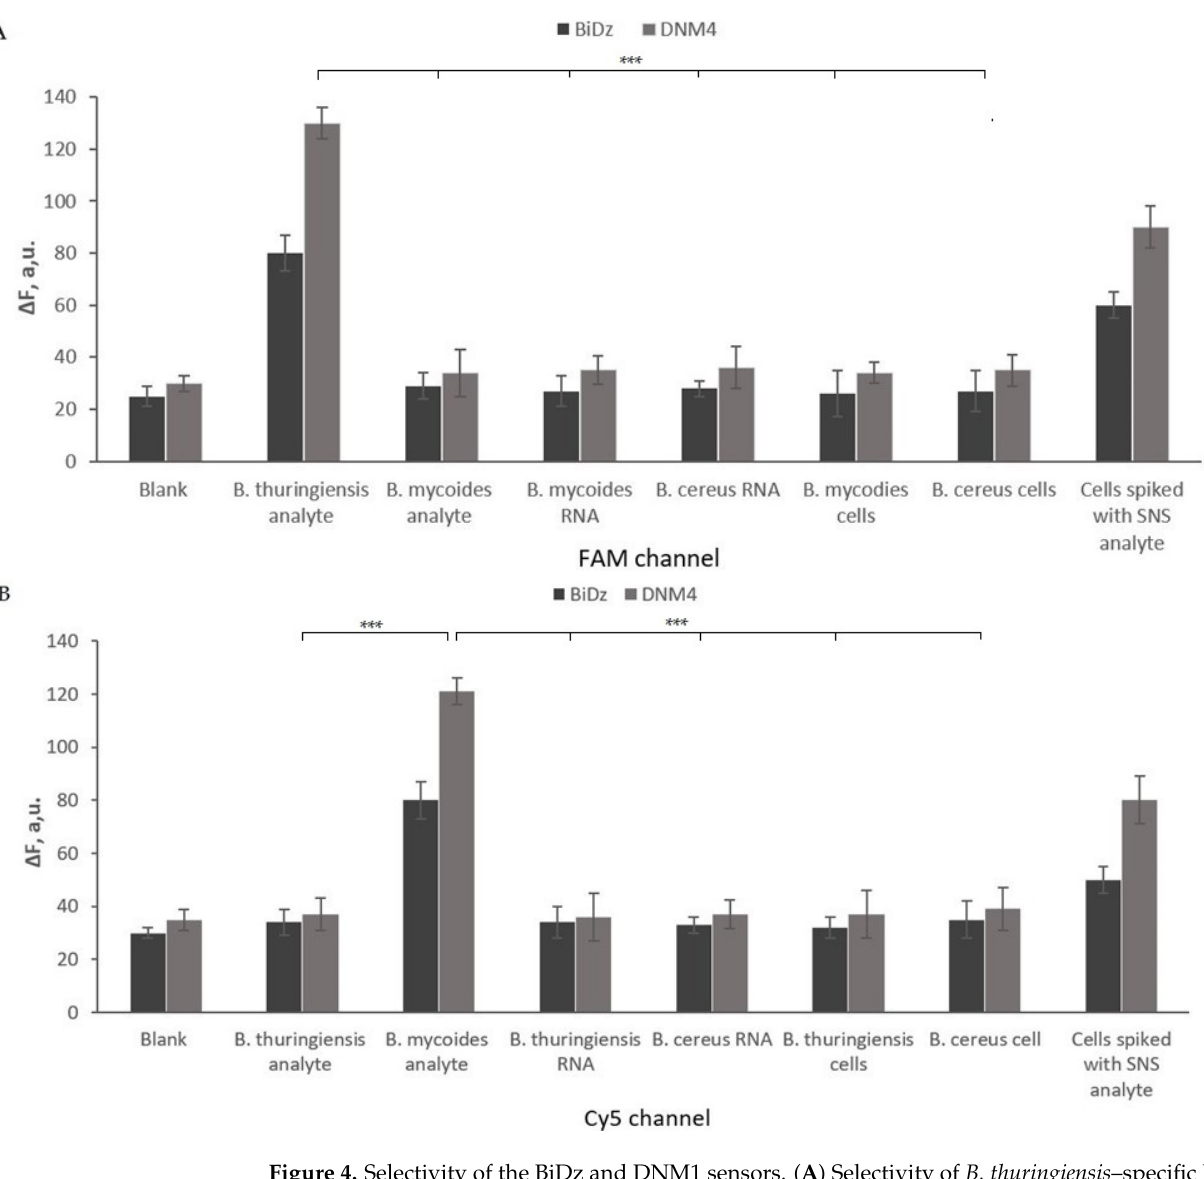
Figure 4. Selectivity of the BiDz and DNM1 sensors. ( A ) Selectivity of B. thuringiensis –specific BiDz (dark gray bars) and DNM4 (light gray bars) in the presence of either synthetic oligonucleotides analyte ( B. thuringiensis or B. mycoides analyte) (200 pM), total RNA from either B. mycoides or B. cereus (2 ng, 1.5–1.6 million of genome equivalents (GE) of B. cereus and B. mycoides , respectively), B. mycoides or B. cereus cell and B. mycoides cells spiked with B. thuringiensis analyte (200 pM after 1 h of incubation at 55 °C in the FAM channel). Blank sample contained no analyte. ( B ) Same as in panel A, but for B. mycoides –specific BiDz and DNM4. The samples contained 2 ng (1.4 million GE) of B. mycoides total RNA corresponds. The signal was read at Cy5 channel. Average values of three independent measurements are presented with one standard deviation. ***: p value < 0.001. Table S4 and Table S5 contain data correspond to Figure 4A and Figure 4B, respectively.